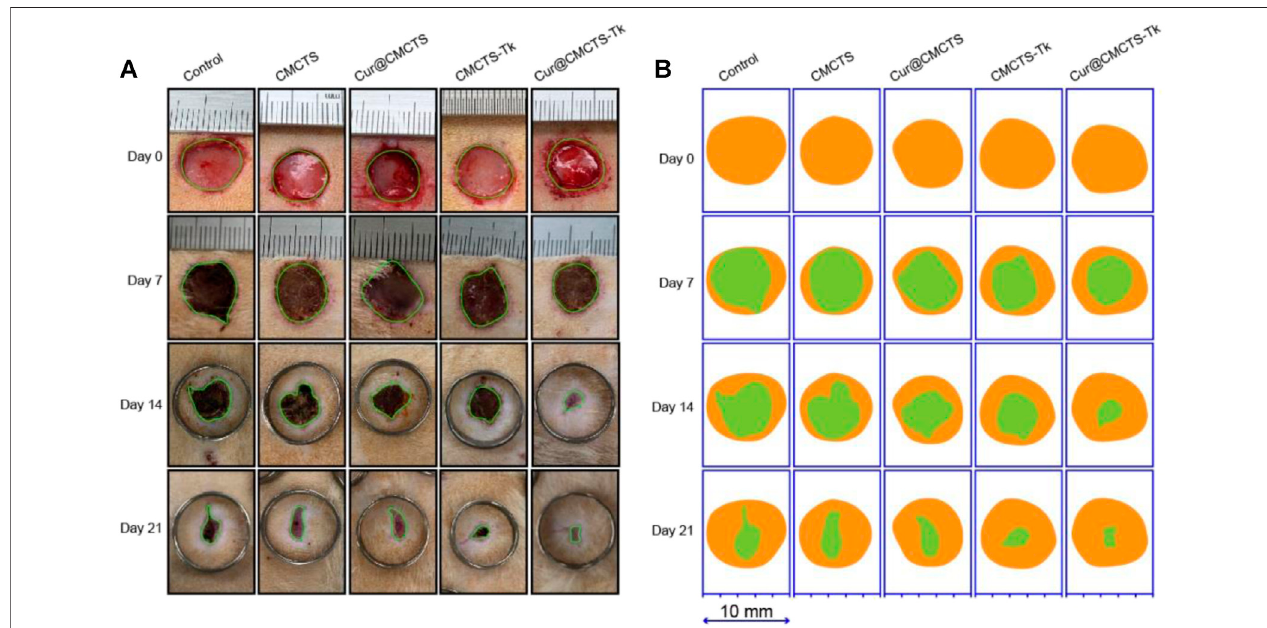
FIGURE 7 | (A) Digital photos of wounds on the dorsum of rats after treatment by Cur@CMCTS-Tk hydrogel for up to 21 days using no treatment, CMCTS, Cur@ CMCTS,andCMCTS-Tkhydrogelasthecontrols.Intheearlysevendays,thewoundwasrewettedatanintervalof8 hbytwotothreedropsofPBS(37 ° C),allowingCur delivery; (B) wound trace was drawn by Adobe Illustrator software. Yellow: 0 d, green: real-time day. The data were represented as mean ± SD ( n (cid:2) 3) (* p < 0.05, ** p < 0.01, *** p < 0.001).